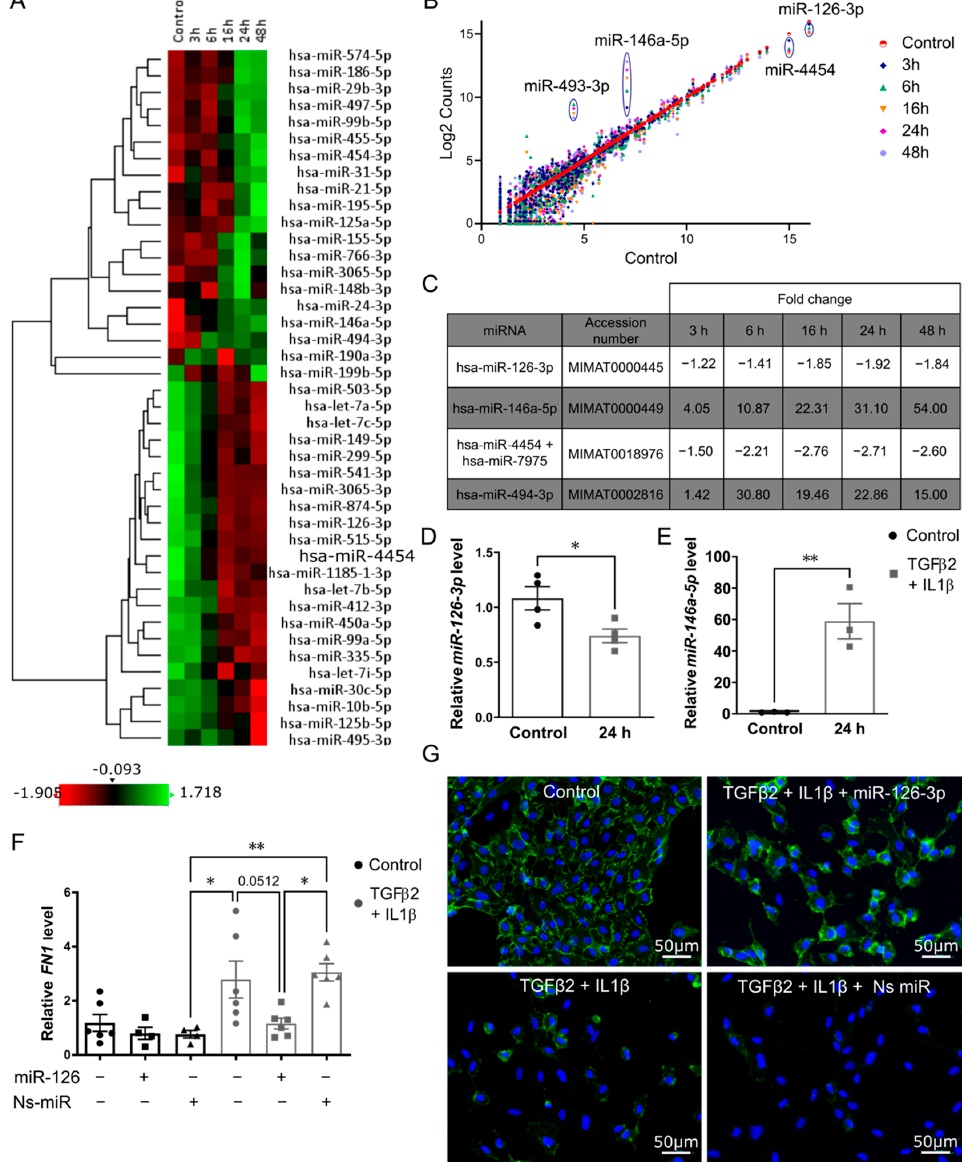
Figure 2. MiR126-3p partially prevents TGF β 2-IL1 β -induced EndMT in primary endothelial cells. HUVECs were treated with 10 ng/mL TGF β 2 and IL1 β for 3, 6, 16, 24 or 48 h. Total RNA was isolated and miRNAs expression was assessed with the nCounter miRNAs expression panel. ( A , B ) Heatmap and scatter plot of the differentially expressed miRNAs in all samples ( n = 2). Red and green colours represent decreased and increased expression of miRNAs, respectively ( C ) Fold change of miRNAs expression in treated cells compared to control ( D , E ) MiR-126-3p ( n = 4) and miR–146a- 5p ( n = 3) expression by qRT-PCR. Expression of miRNAs was normalized to endogenous controls RNU48 and RNU6, respectively. ( F ) HUVECs were transfected with 50 nM of miR-126-3p mimics using lipofectamine followed by TGF β 2 and IL1 β (10 ng/mL) treatment. Transfection of non-specific miRNA (50 nM) was used as the control. Gene expression level of fibronectin was decreased post-transfection in endothelial cells undergoing EndMT. Gene expression was normalised to the expression of the housekeeping gene Hprt1.( n = 6) ( G ) Post-transfection, staining for the endothelial marker CD31 showed miR-126-3p promoted retention of an endothelial phenotype in the presence of TGF β 2 and IL1 β . Error bars are the standard error of the mean. Statistical significance was calculated by unpaired t -test and One way ANOVA (* p < 0.05; ** p <